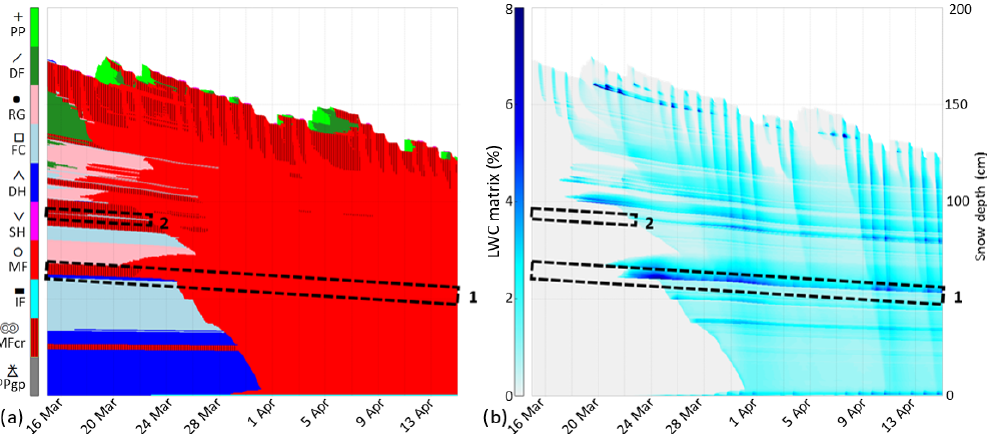
Figure 11. SNOWPACK simulation RE/PF from 15 March to 15 April 2017 at WFJ: (a) grain shape according to the classification of Fierz et al. (2009), and (b) liquid water content in the matrix domain. Rectangles highlight layers 1 and 2.